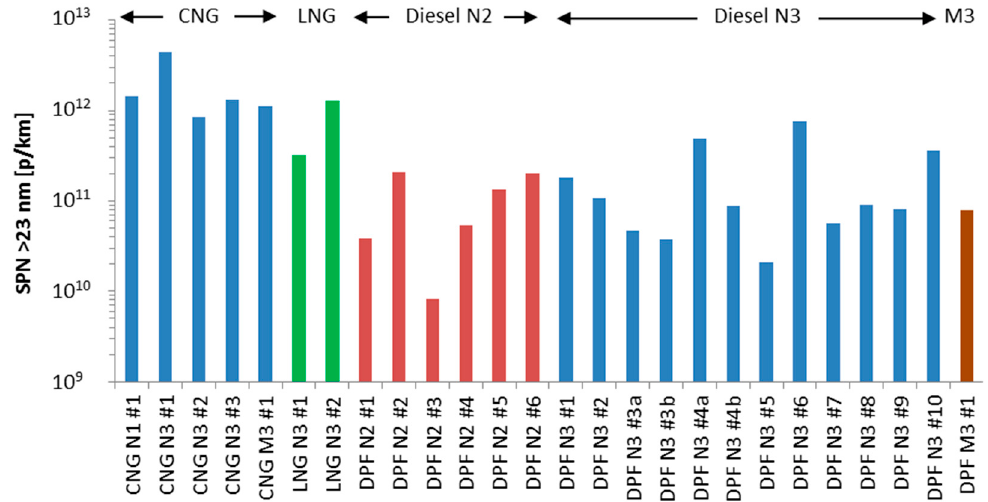
Figure 2. Weighted SPN emissions of test fleet (14% cold start, 86% mean of urban, rural, motorway). The small letters “a” and “b” indicate testing of the same vehicle after approximately 3–6 months.